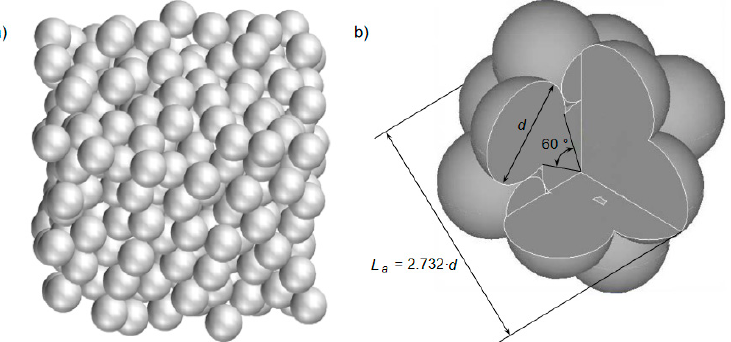
Figure 2. ( a ) Portion of a random packing of spherical particles (porosity = 30%); ( b ) Scheme of the sphere arrangement used to represent an agglomerate of spheres [45].